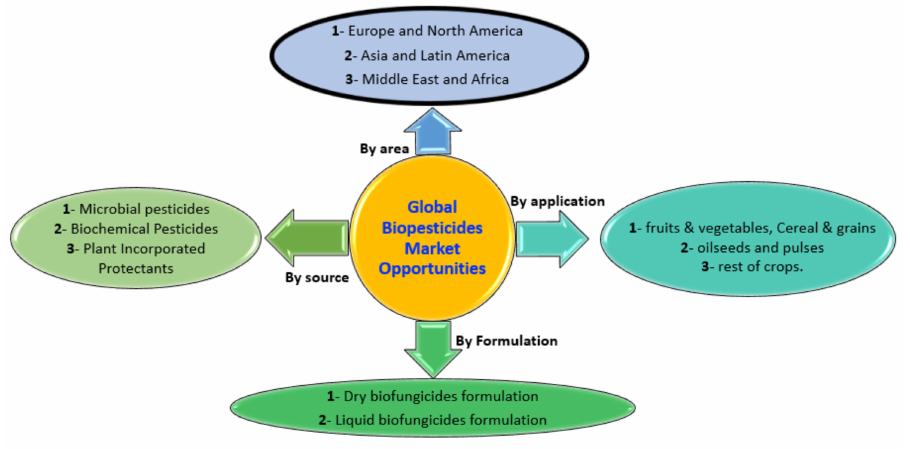
Figure 4. The potential market of